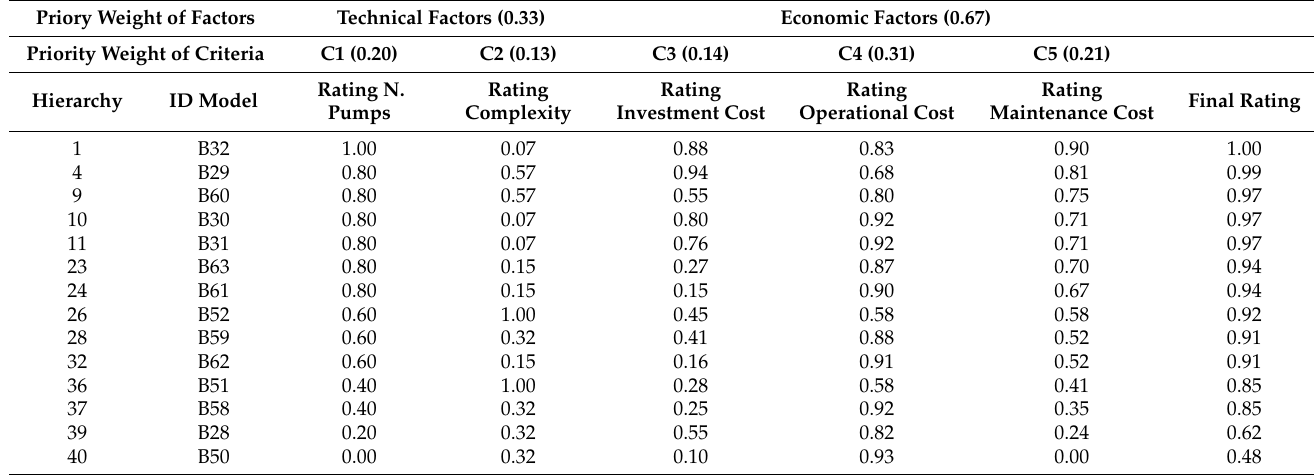
Table 11. Rating of the criteria and overall rating for each alternative